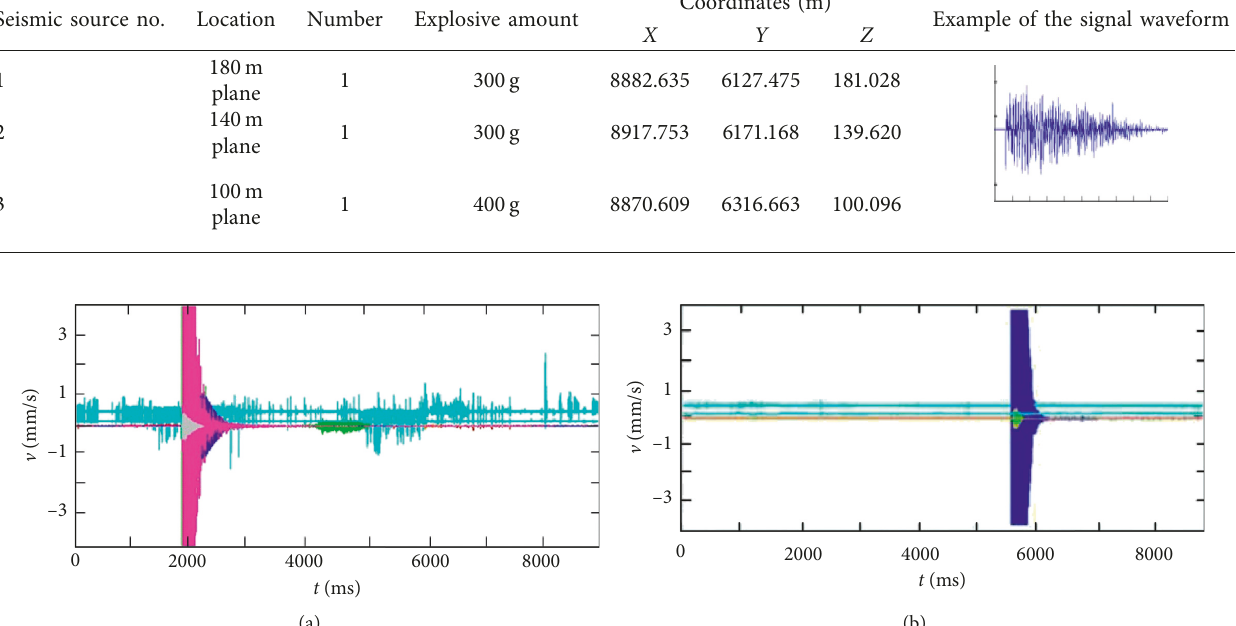
Figure 6: Microblasting signal. (a) No. 2 seismic source signal at the 100 m plane. (b) No. 3 seismic signal at the 140m plane.